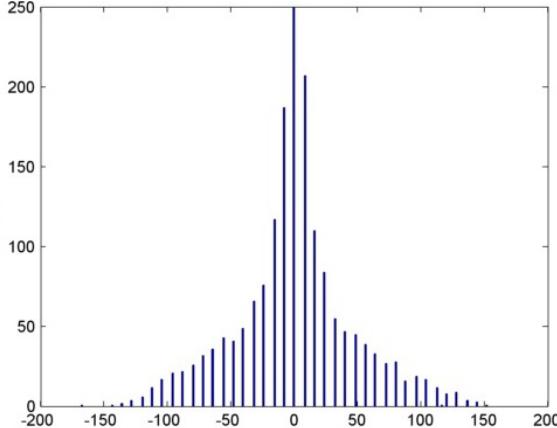
Figure 9. Histogram of the image horse after applying delta